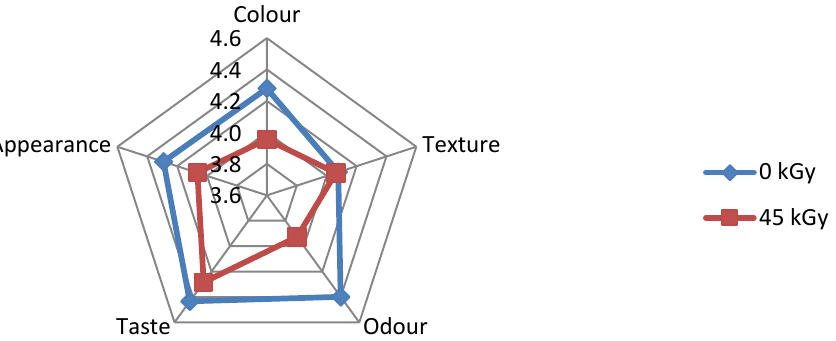
Figure 5. Sensory evaluation of non-irradiated and irradiated semur beef.